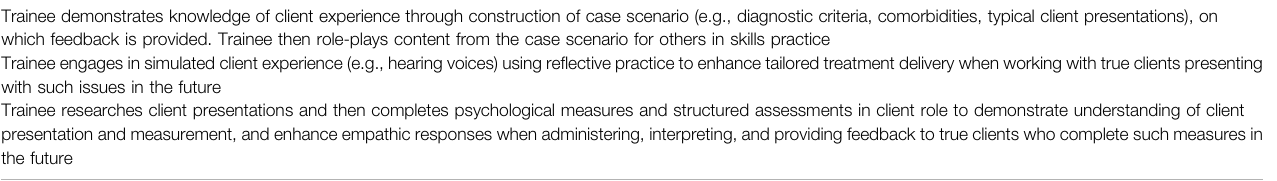
TABLE 3 | Examples of experiential client perspectives.